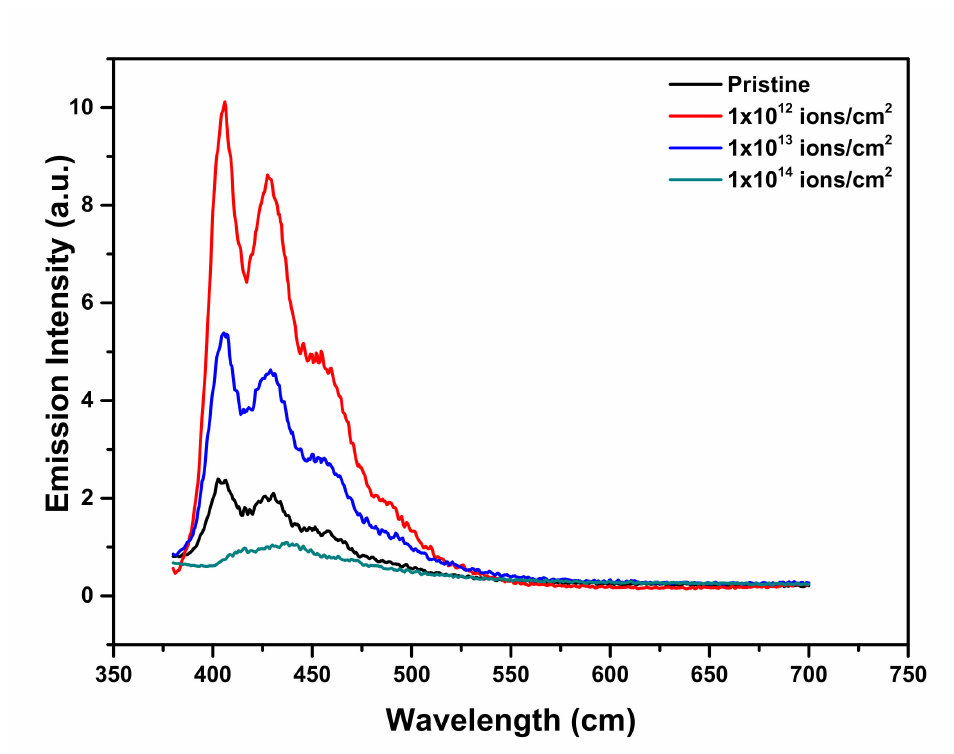
Figure 6. Photoluminescence spectra of pristine and Cu + implanted PMMA.